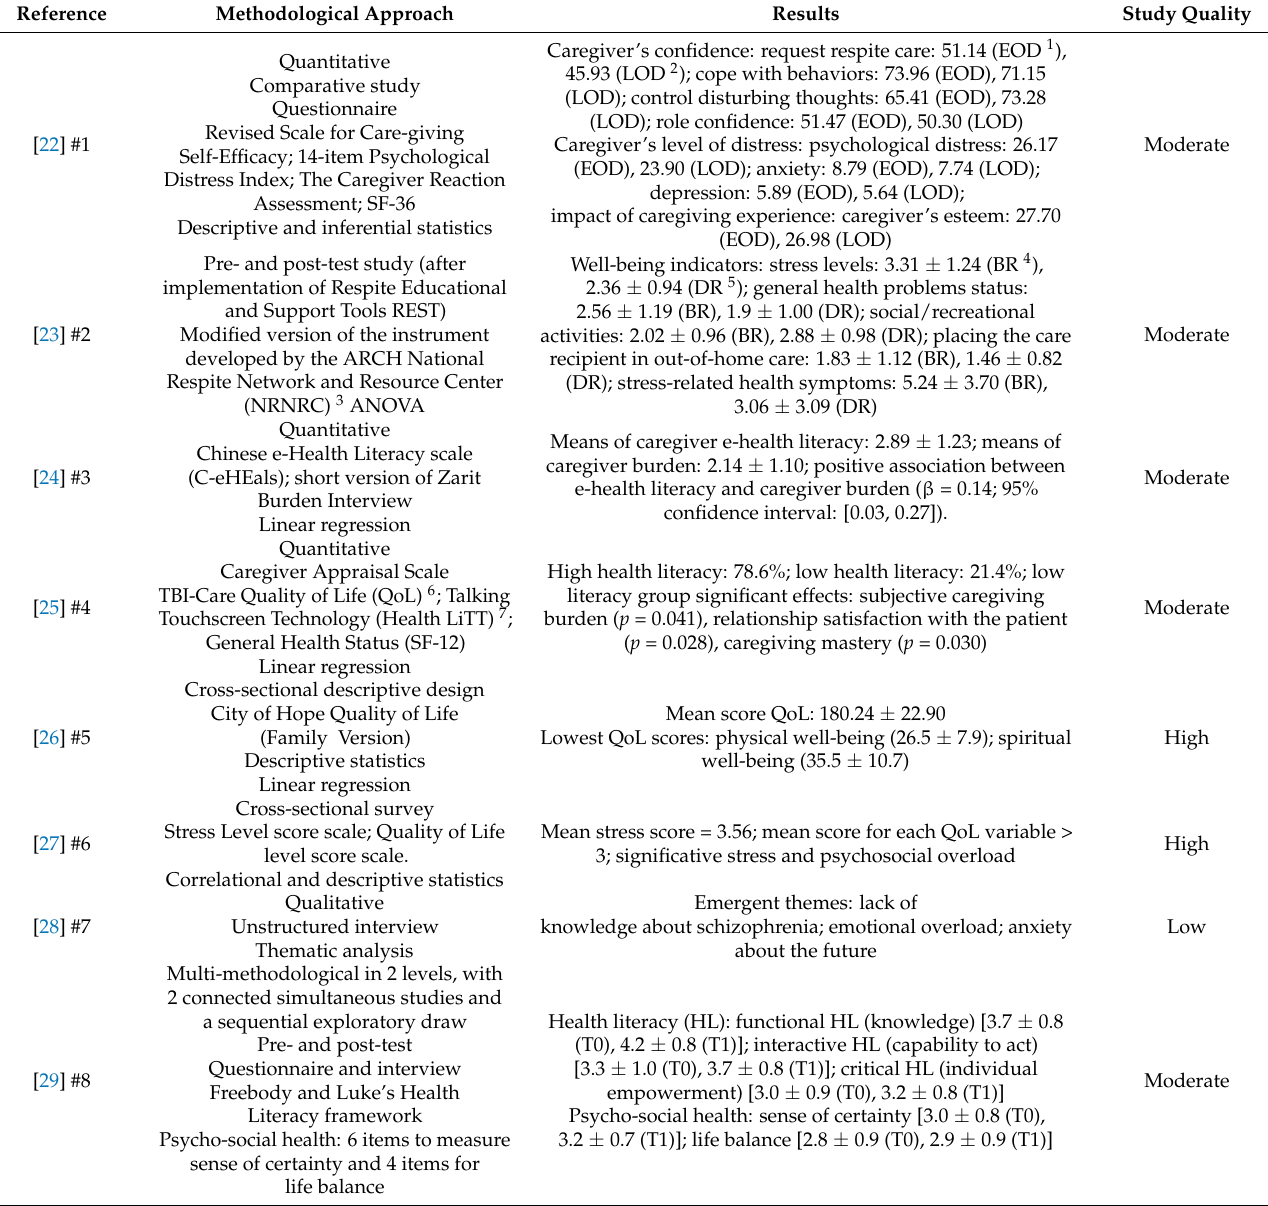
Table 2. Methodological approach and results of the studies selected for